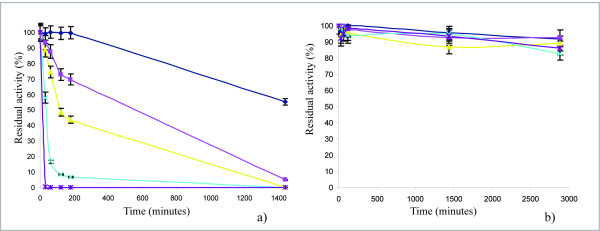
Effect of temperature (a) and pH (b) on the stability or the purified TrLAC1. Selected temperatures were 30°C "blue diamond", 35°C "pink square", 40°C "yellow triangle", 45°C "blue cross", 50°C "purple star" and the selected pH values were 3 "blue diamond", 4 "pink square", 5 "yellow triangle", 6 "blue cross", 7 "purple star".